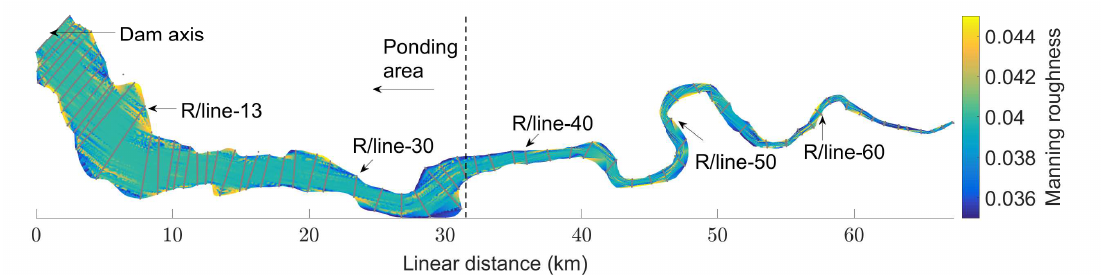
Figure 8. Interpolated Manning roughness ( n ). Grey lines represent the measurements along the cross sections/range lines